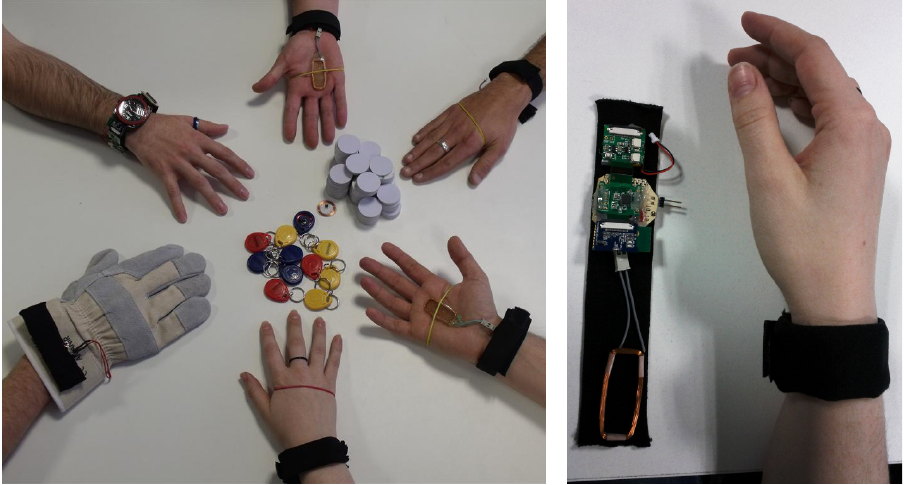
Figure 2. Different prototypes of our RFID Tag reader, such as a glove, a bracelet and a watch ( left ). The final prototype used in our evaluations ( right